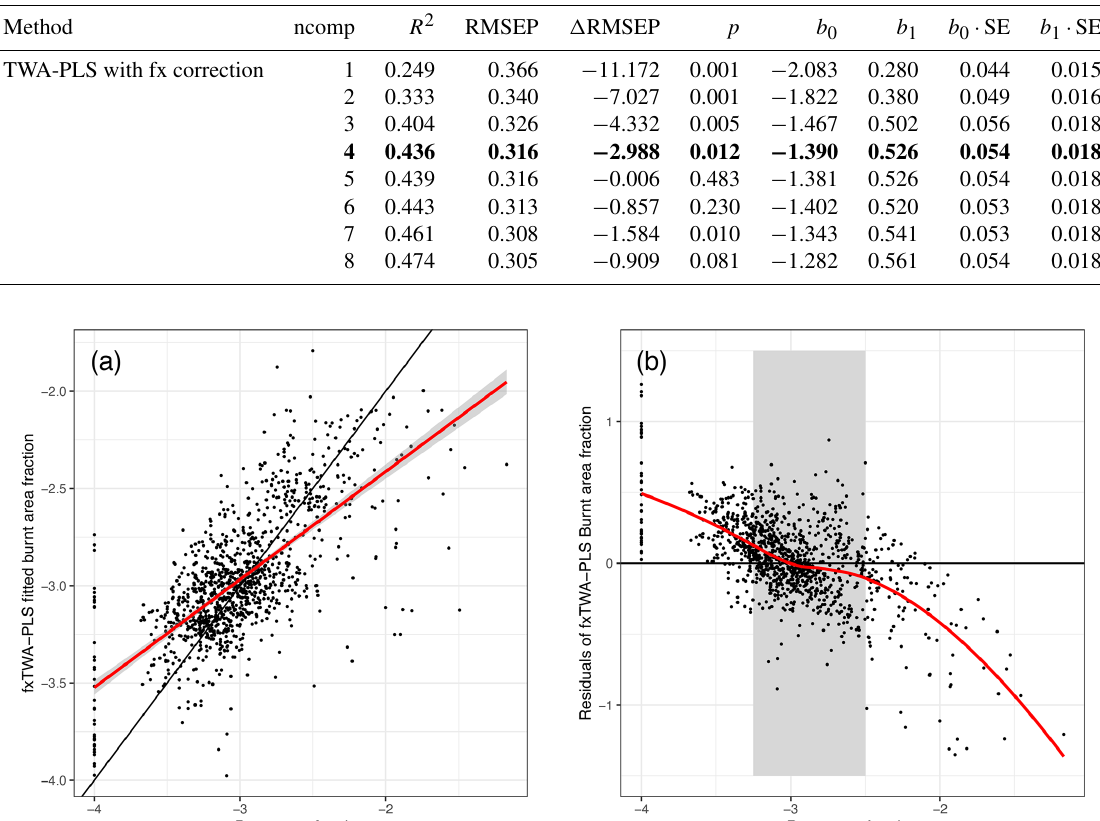
Table 2. Leave-out cross-validation fitness of the fxTWA-PLS method, showing results for all the components. The last significant number of components are shown in bold. RMSEP is the root mean square error of prediction. (cid:49) RMSEP is the percent change of RMSEP using the current number of components (ncomp) than using one component less. b 0 , b 1 , b 0 · SE, and b 1 · SE are the intercept, slope, standard error of the intercept and standard error of the slope of the linear regression using the cross-validation result and burnt area data converted from charcoal abundance.